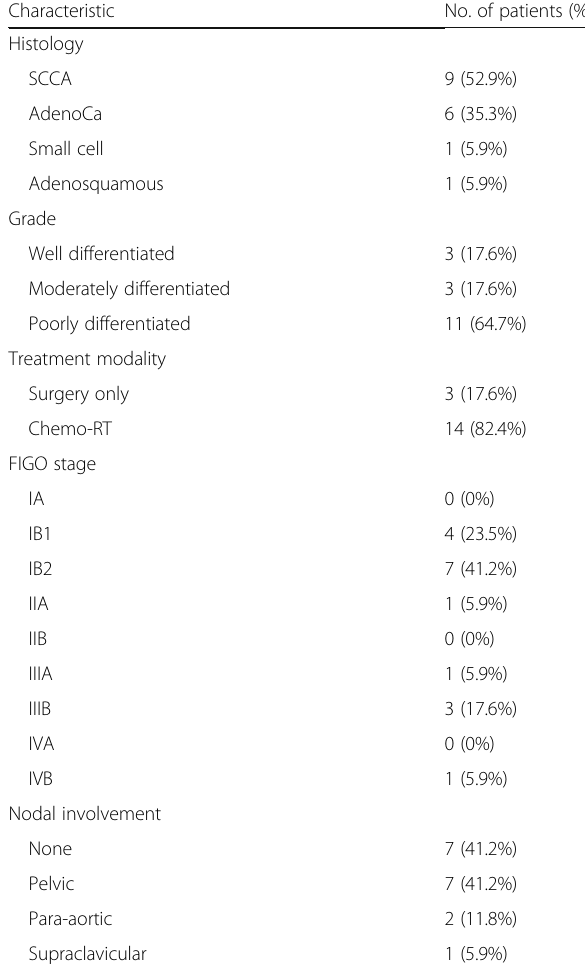
Table 1 Characteristics of the patient cohort Characteristic